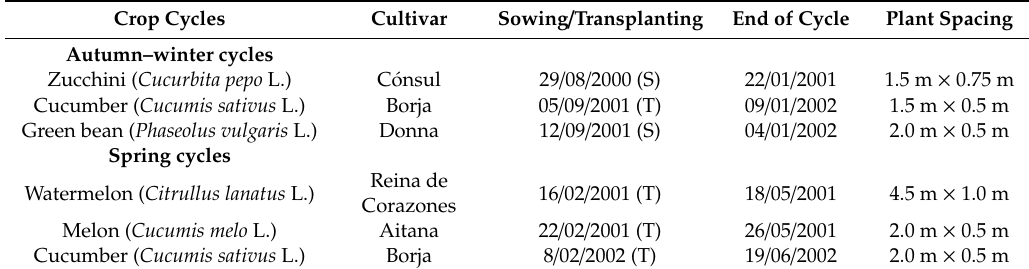
Table 1. Crop, variety, date of sowing (S) or transplanting (T) and end of the cycle, and plant spacing of greenhouse experiments. Almer í a,